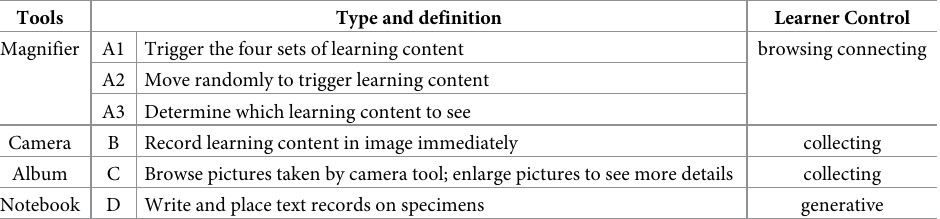
Table 1. The design of the AR learner control